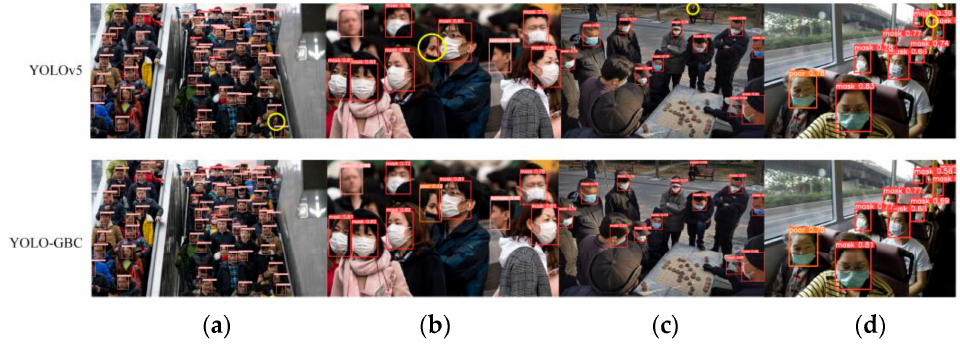
Figure 11. Comparison of detection effect. ( a ) crowded scene. ( b ) face is severely blocked. ( c ) small target. ( d ) serious occlusion and small target.